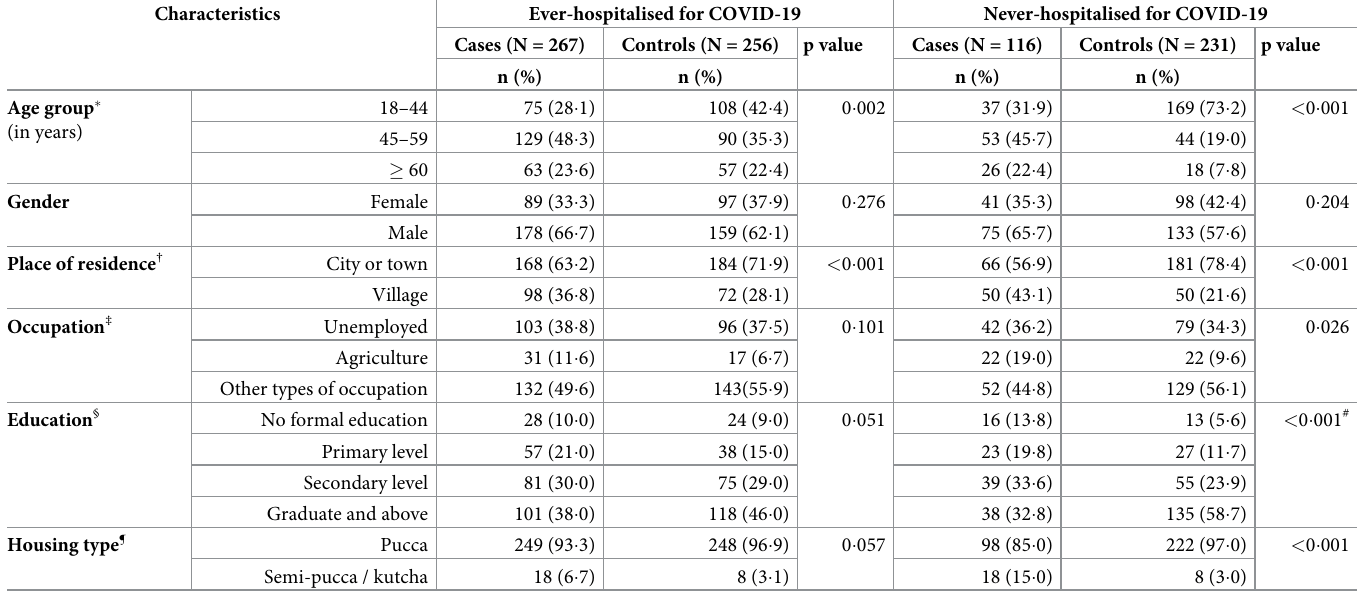
Table 1. Socio-demographic characteristics of the cases and controls, multi-centric case-control study of post-COVID rhino-orbito-cerebral mucormycosis, India, 2021.